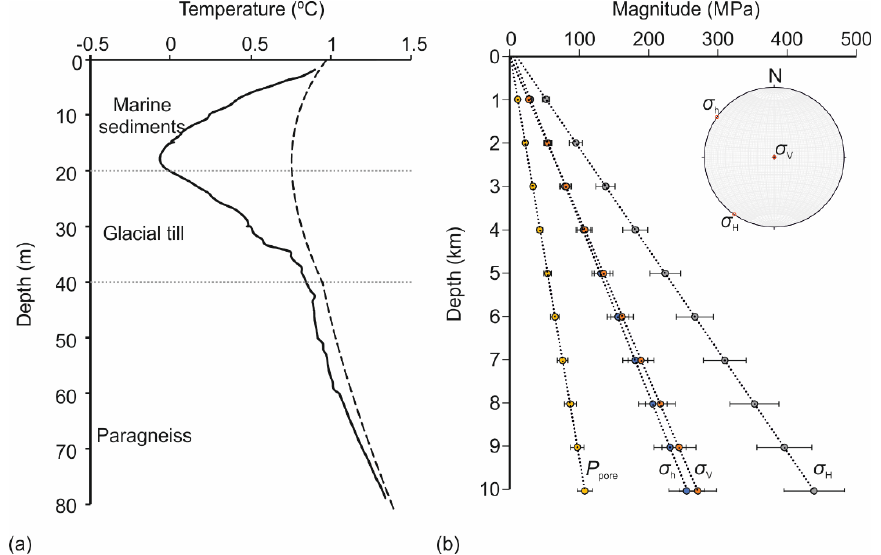
Figure 4. ( a ) Measured (solid line) and simulated (dashed line) temperature profile near the community of Kuujjuaq. The simulated profile corresponds to a heat flux of 41.6 mW m − 2 at 10 km depth (reprinted with permission from Miranda et al. [49], 2021 Elsevier Ltd.); ( b ) magnitude and orientation of the principal stresses. The error bar represents the range of values inferred. σ H —maximum horizontal principal stress, σ h —minimum horizontal principal stress, σ V —vertical principal stress, P pore —in situ fluid pressure.